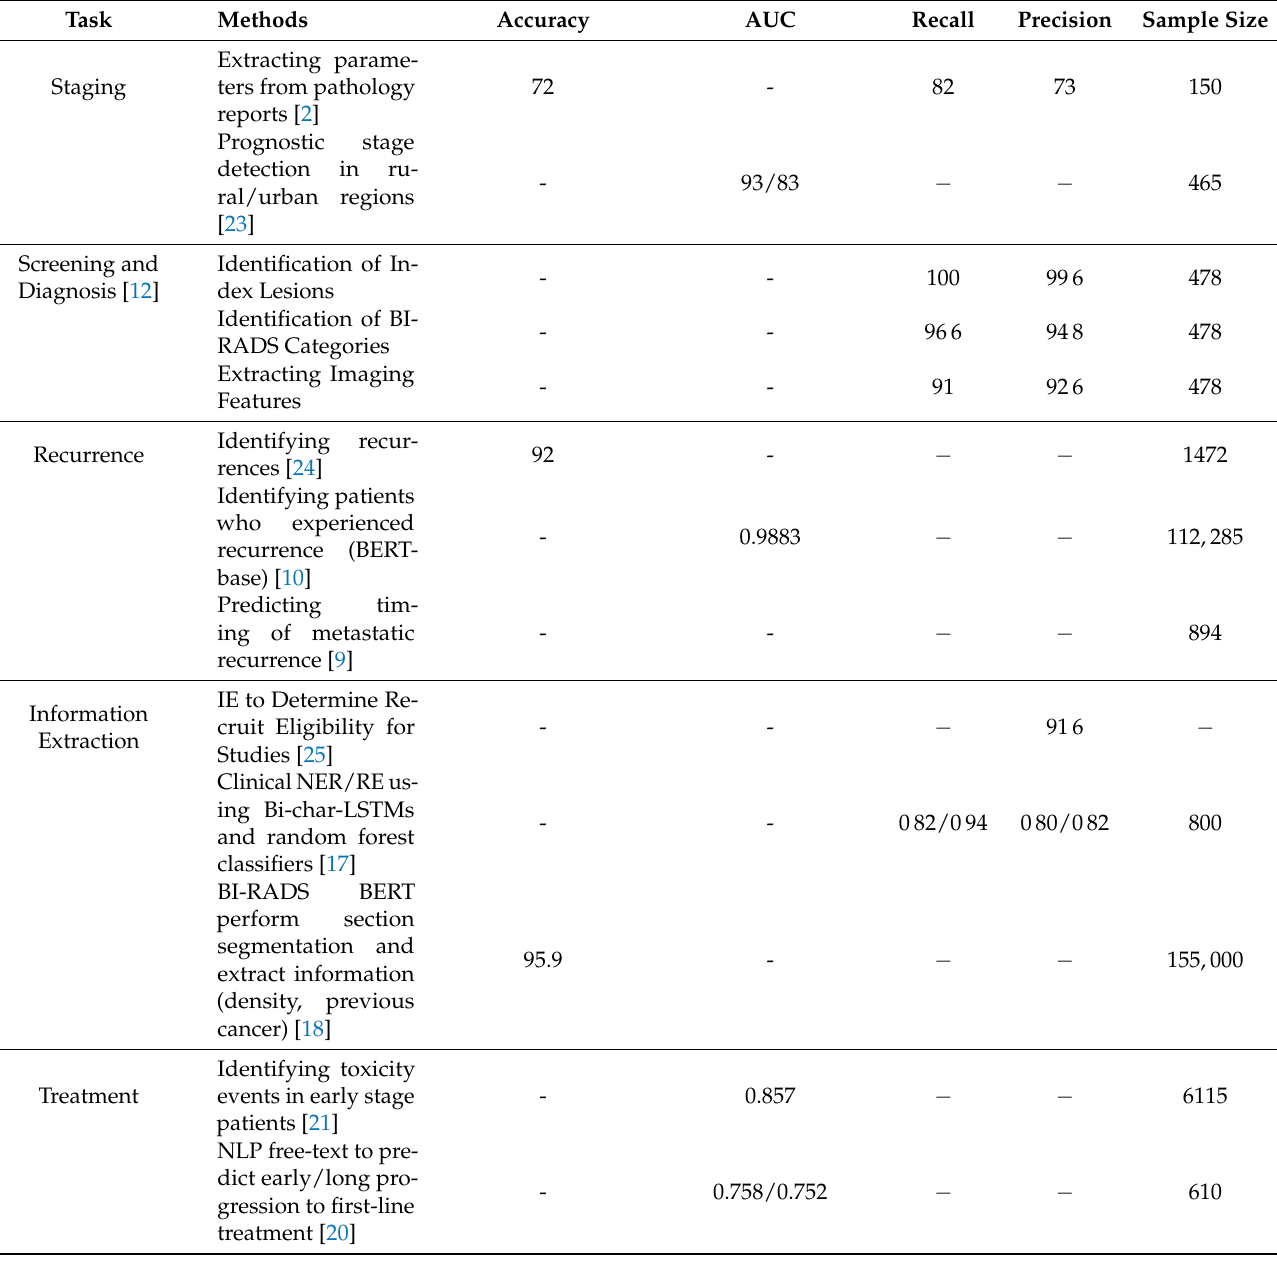
Table 4. Performance of NLP studies in different categories and its sample